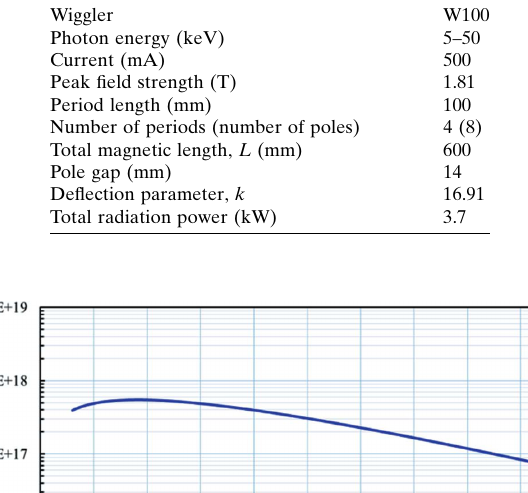
Table 1 Parameters of the TPS insert device and wiggler. Wiggler